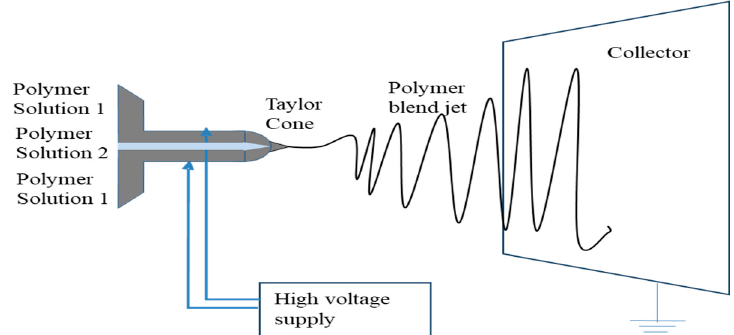
Figure 4. Coaxial electrospinning schematic diagram: Polymer solution 2 is passed through the inner capillary tube, while polymer solution 1 is passed through the outer capillary tube. The Taylor cone is formed where the inner solution (polymer solution 2) is surrounded by the outer solution. The jet erupts from the Taylor cone, and during that process, the polymer in the inner layer is coated with the polymer in the outer layer. The dried fiber with a core-shell design is then deposited on the collector.